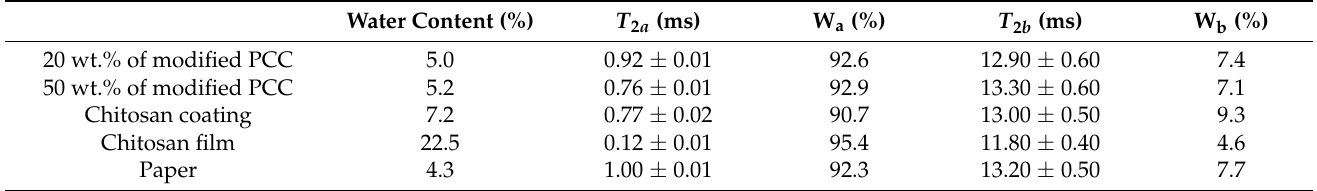
Table 5. T 2 relaxation spin–spin for paper, coatings and chitosan film. Intensities of signals are weighted by sample water content. W a (respectively, W b ) was associated with the ratio intensity of the signal corresponding to T 2 a (respectively, T 2 b